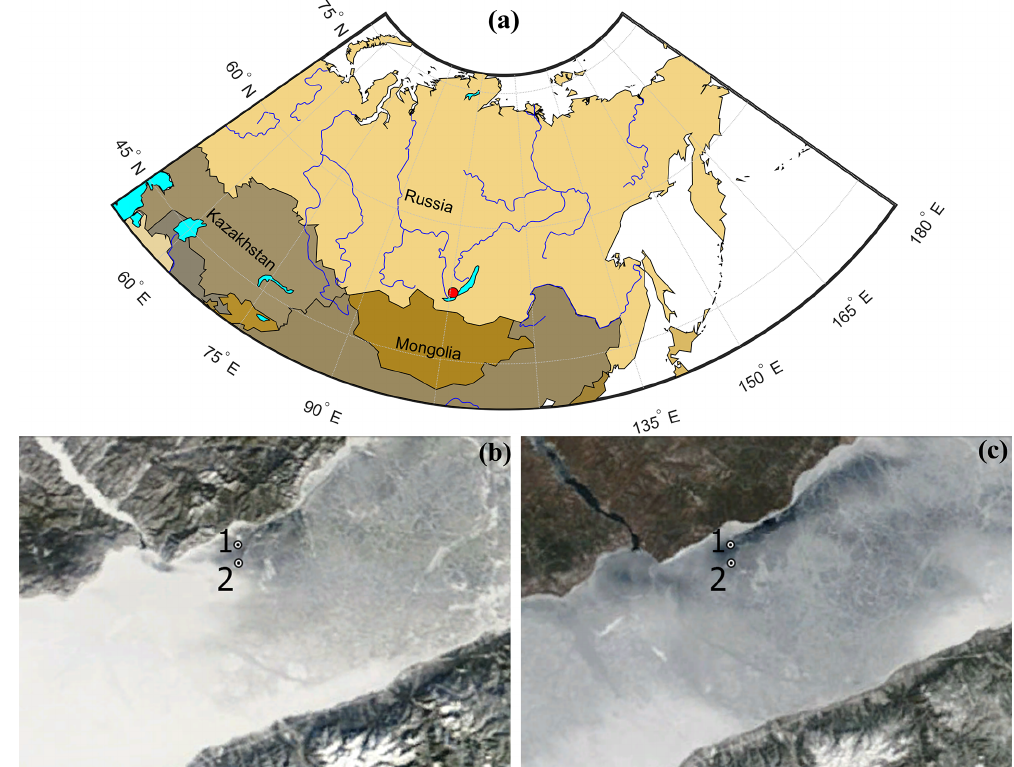
Figure 1. (a) Geographical location of the study site. Ice conditions in the southern part of Lake Baikal on (b) 9 February and (c) 12 April 2017 and locations of the autonomous measurement stations. The satellite images are from the Irkutsk Center of Remote Sensing (sput- nik.irk.ru, 2019). Note the stronger ice melt in the area of the jet current around station S1, visible as a dark area in (c)